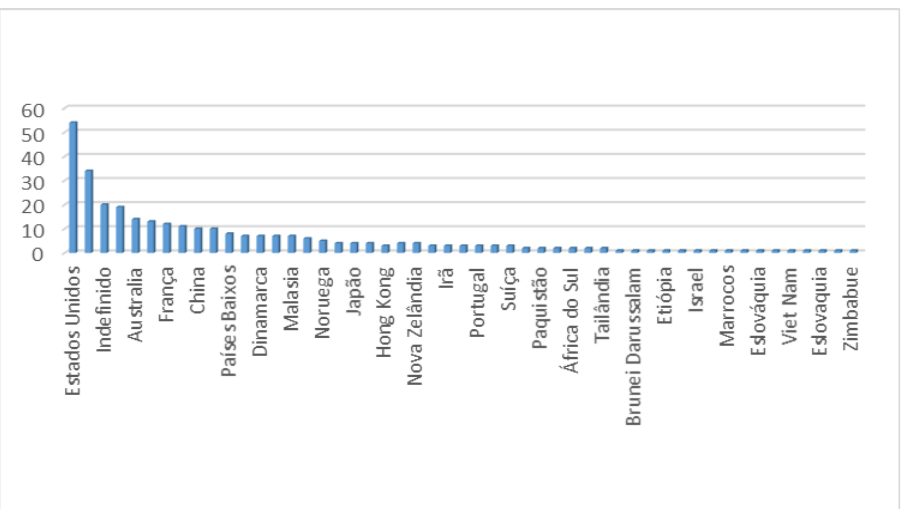
Figure 3. Distribution of research by country